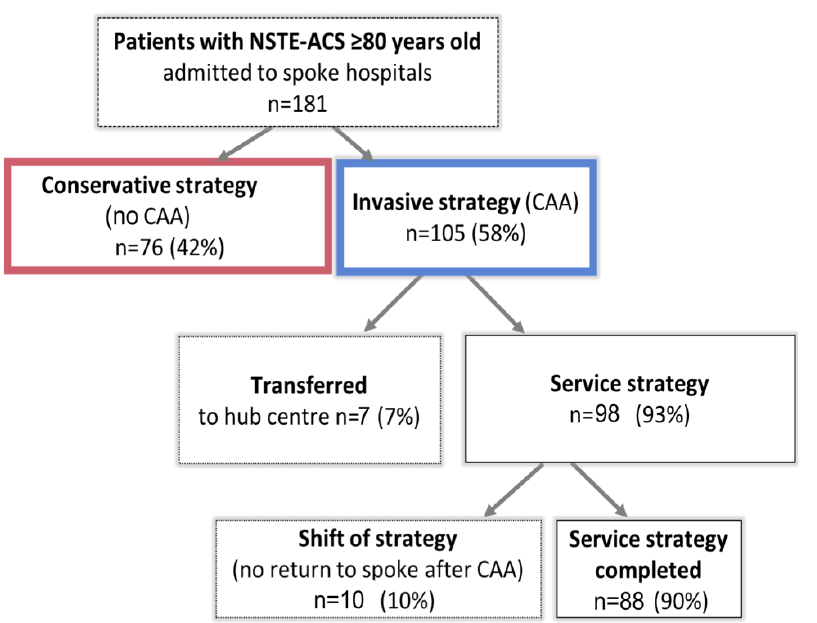
Figure 2. Study population according to the chosen management of NSTE-ACS (non-ST-elevation acute coronary syndrome); CAA (coronary artery angiography).